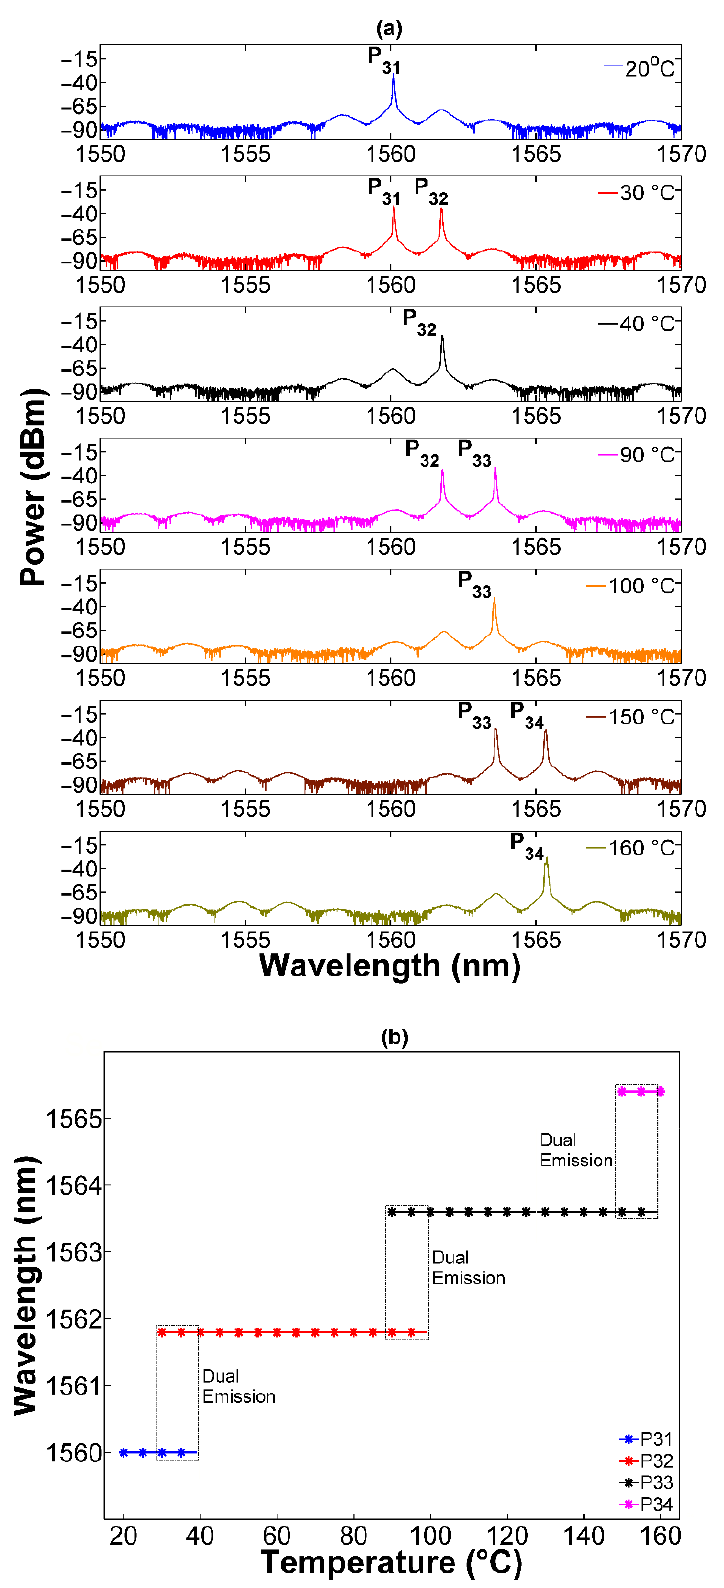
Figure 7. Switchable operation of the EDFL using MZI 2 and MZI 1c in a cascaded configuration, withstanding temperature variations between 20 to 160 ◦ C. ( a ) Laser emissions and ( b )stability analysis of laser emissions against temperature